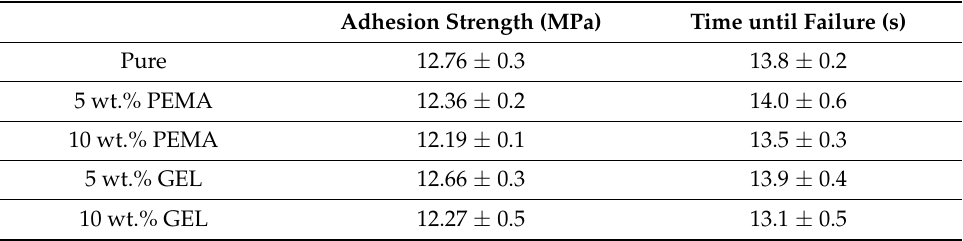
Table 2. Initial scratch depth, 24-h scratch depth and the healing depth differences for the pure epoxy primer, the PEMA microcapsule epoxy primer mix, and the GEL microcapsule epoxy primer mix.